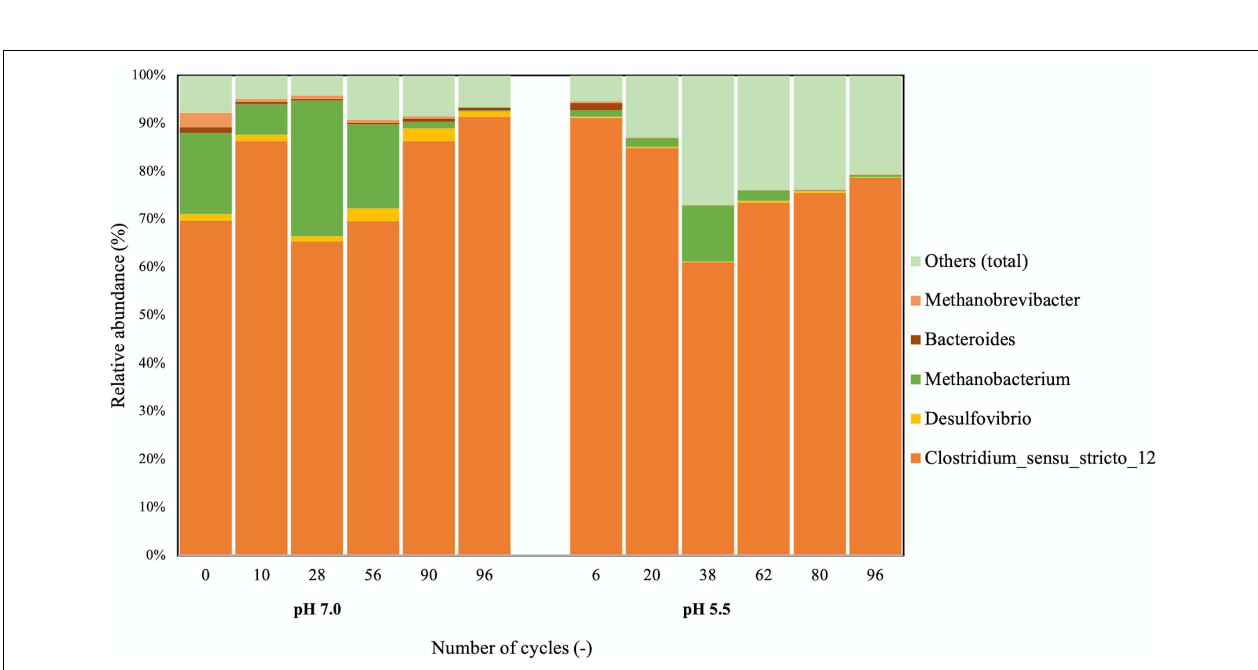
FIGURE 1 | Gas productivities (mmol) per cycle (A,B) and distribution of consumed electrons over the fermentation products (C,D) over time in SBRs at different pH. A single spike of BES was given to the enrichment at pH 7.0 in cycle 40, from cycle 45 onward both enrichments were continuously supplemented with BES. Due to a technical error, gas data of the enrichment at pH 7.0 is missing between cycle 72 and 82. Sudden drops in hydrogen production at pH 5.5 are due to reactor cleaning, after which the biological activity recovers within 4 cycles.